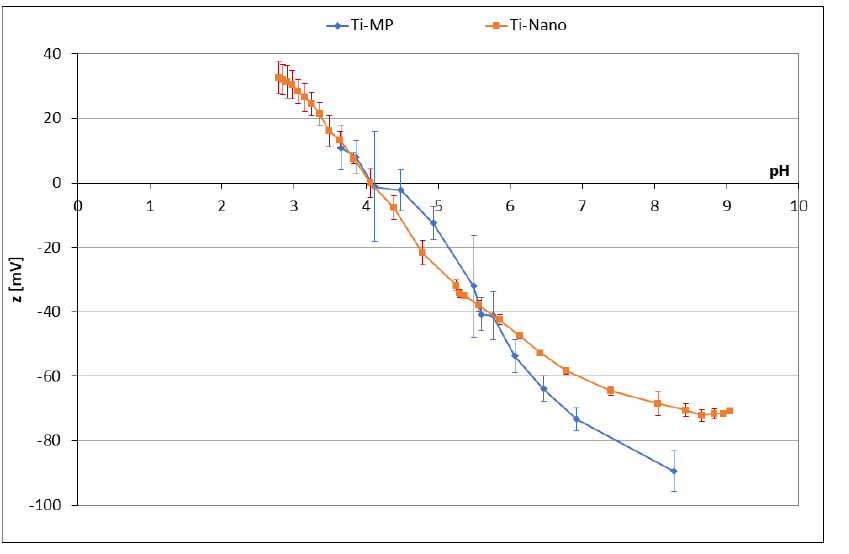
Figure 1. Zeta potential versus pH titrations of Ti-MP and Ti-Nano.